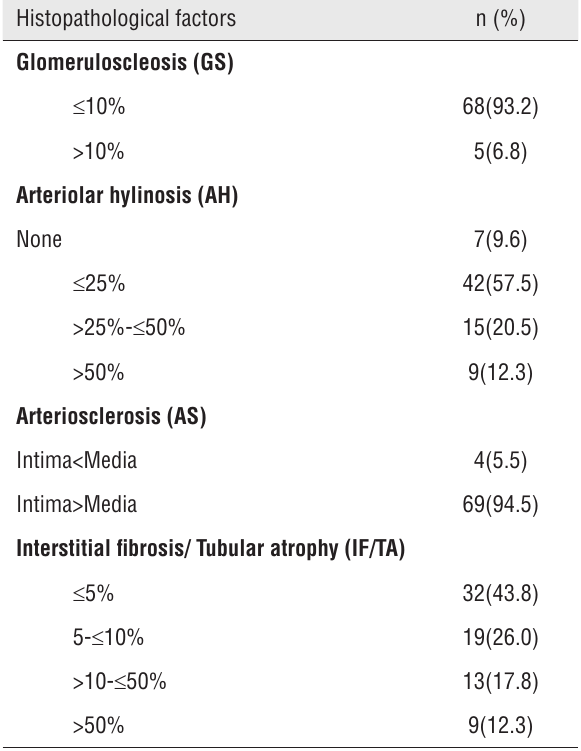
Table 2 - histopathological findings.